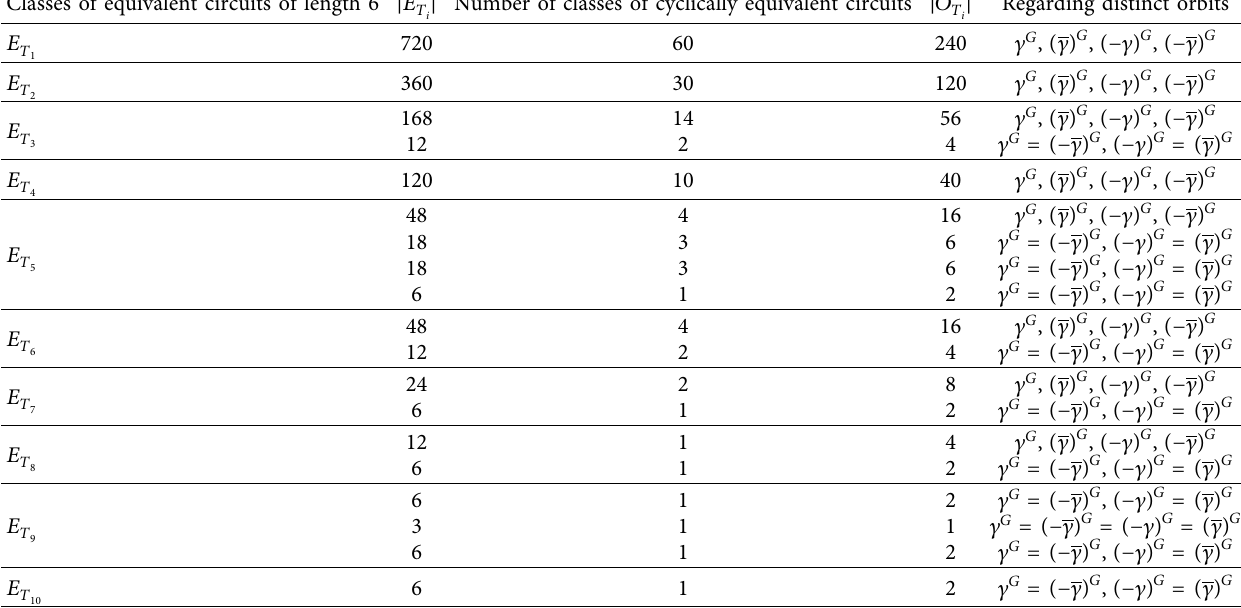
Table 2: Enumeration of orbits.